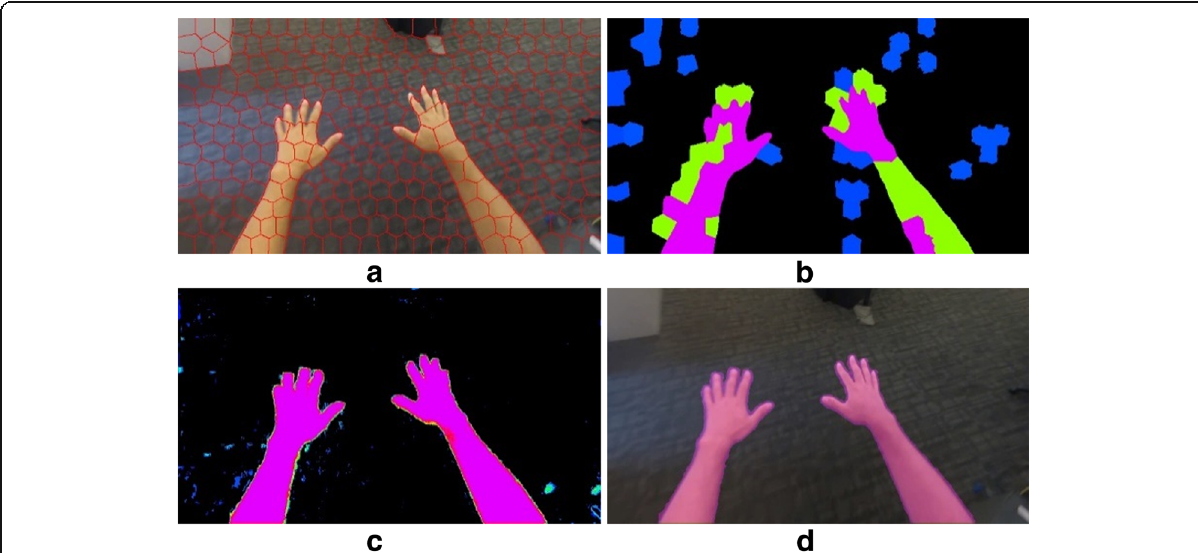
Fig. 4 Example of two-level classification. a – d are superpixel segmentation overlaid on original image, probability map of superpixel-level classification, probability map of pixel-level classification, and final segmentation overlaid on original image